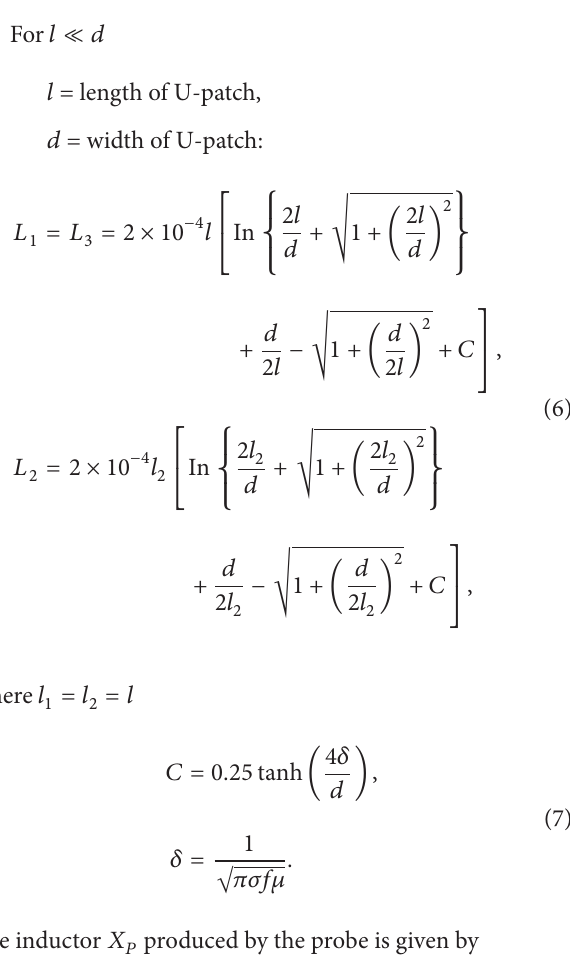
Figure 1: Proposed model.